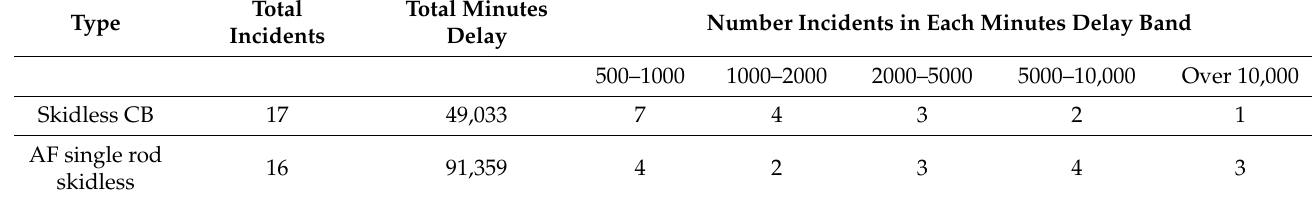
Table 2. Network Rail train delay minutes by neutral section type, 2006–2015 [18–20].